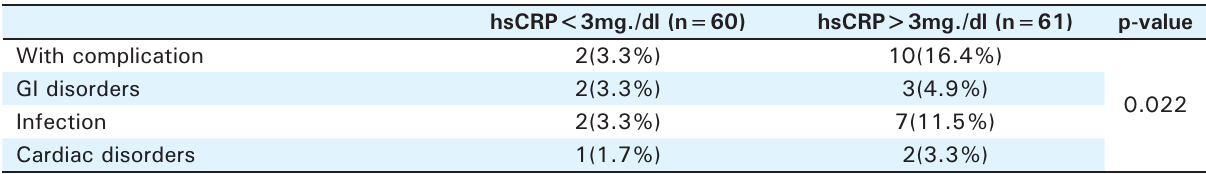
Table 5. Comparison of post operative morbidity on D-14 among study subjects grouped according to hsCRP level <or>